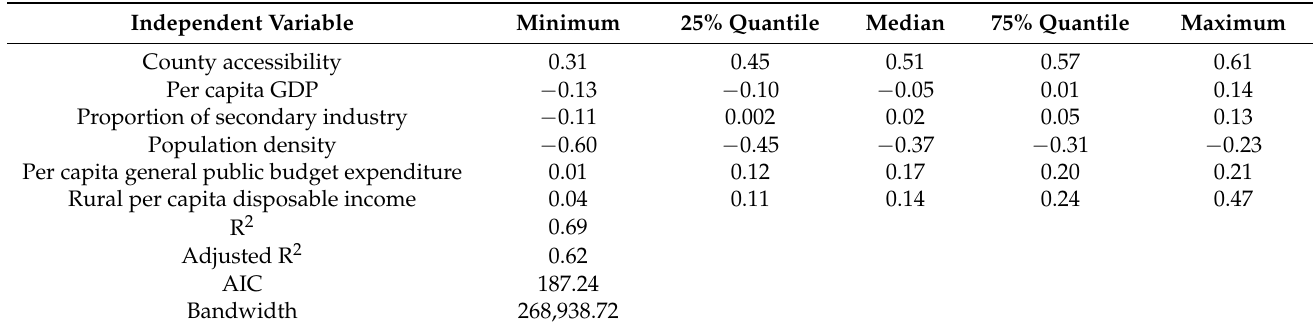
Table 7. Results of GWR model regression